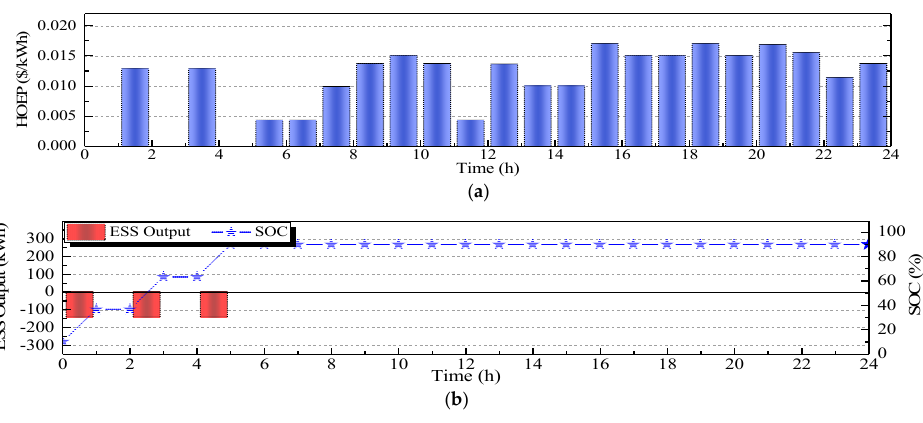
Figure A2. Results of Case 1: ( a ) Forecasted HOEP; ( b ) Scheduled output and SOC of the ESS. Case 2 Compared with Case 1, the maximum value of the forecasted HOEP was slightly increased to 0.019 $/kWh